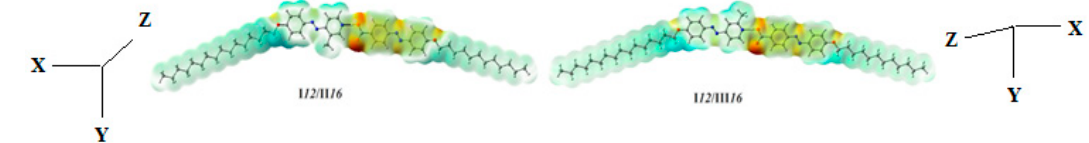
Figure 7. Molecular electrostatic potential (MEP) of I 12 /II 16 and I 12 /III 16.